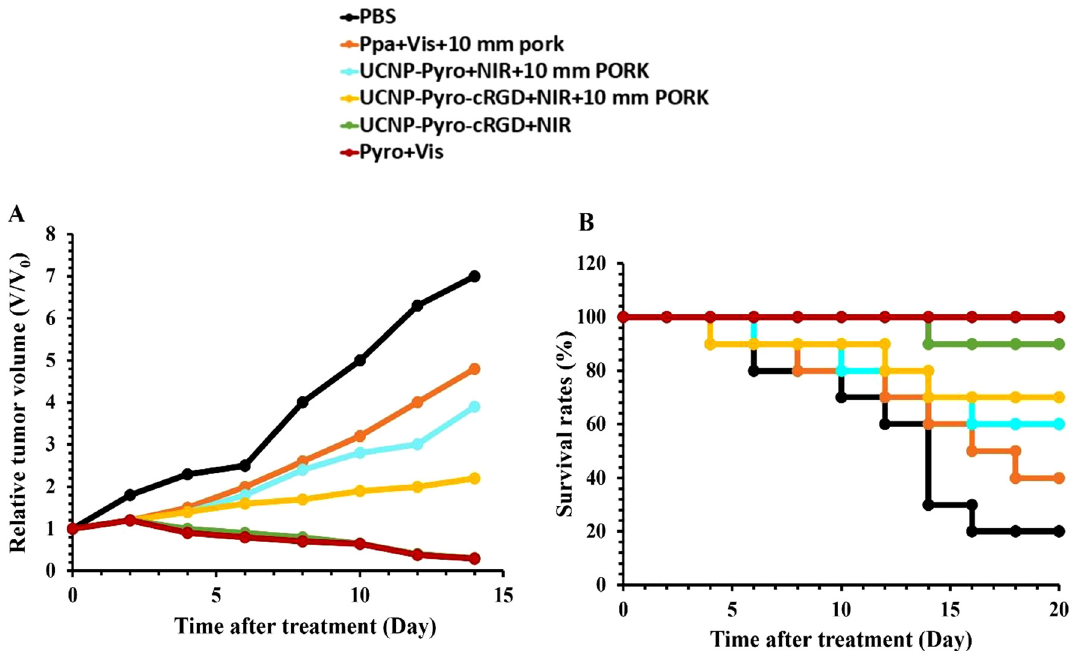
Figure 22: In vivo PDT treatment with same concentration of pyro (10 µM). (A) time-dependent tumor growth rate, 14 days after the PDT treatment(B) micesurvival rate after differentkindsof PDT treatment with light excitationat 635 nm forVis and 980 nm forNIR (500 mW cm − 2 ) for 1 min. Adapted from Zhou et al. [48].